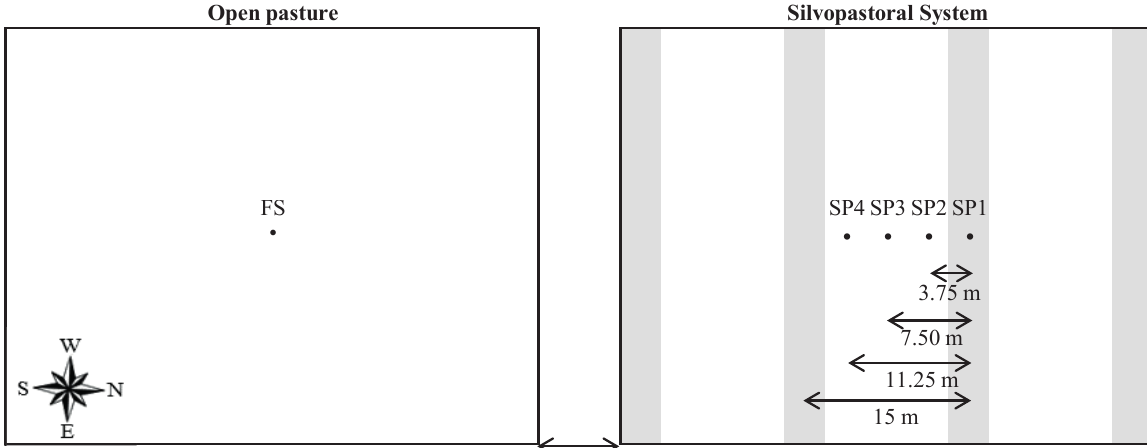
Figure 1. Schematic representation of the study area indicating where the data were collected in the open pasture (left) and in the silvopastoral system (right). FS: full sun, SP1: 0.00 m, SP2: 3.75 m, SP3: 7.50 m, SP4: 11.25 m from North row. Gray strips illustrate the tree